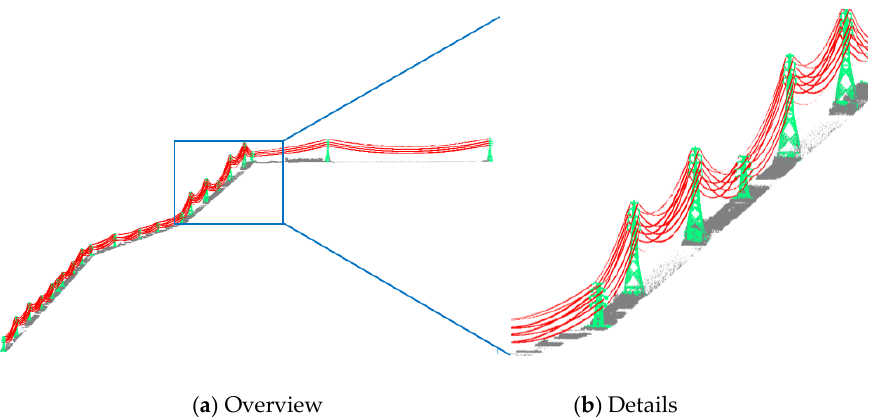
Figure 10. Power line extraction results of ROW 1.